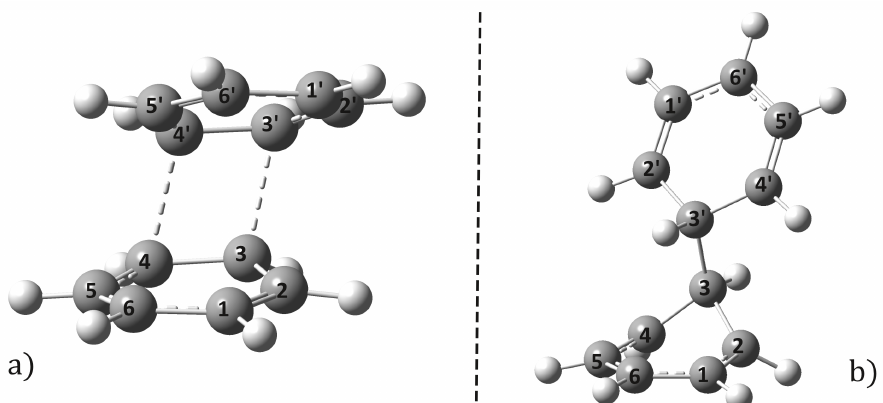
Figure 3. The two (( a ) parallel and ( b ) antiparallel ) dimer-type conical intersection geometries of benzene dimer computed at CASSCF(12,11)/6–31G(d,p) level of